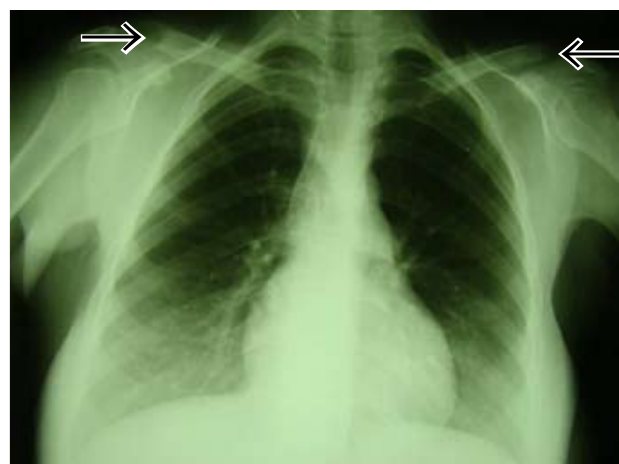
Fig. 15c. Posteroanterior X-ray of the chest with bilateral soft-tissue neurofibro- mas eroding the lateral ends of the clavicle.